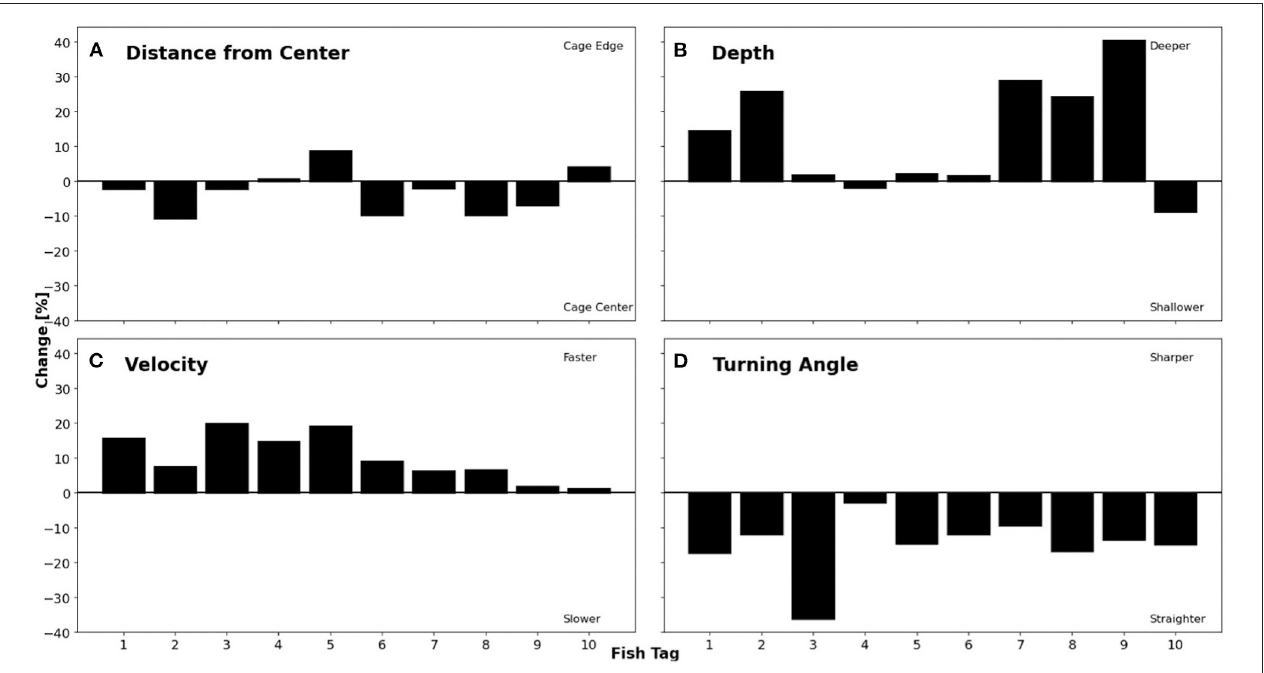
FIGURE 8 | Percent change of individual fish comparing feeding times to non-feeding times. (A) Change in distance from centre where a positive change represents a shift towards cage edge. (B) Change in depth where a positive change signifies movement towards the bottom of the net pen. (C) Change in velocity where an increase in velocity is represented by a positive change. (D) Change in turning angle with a negative change characterising a straighter turning angle.